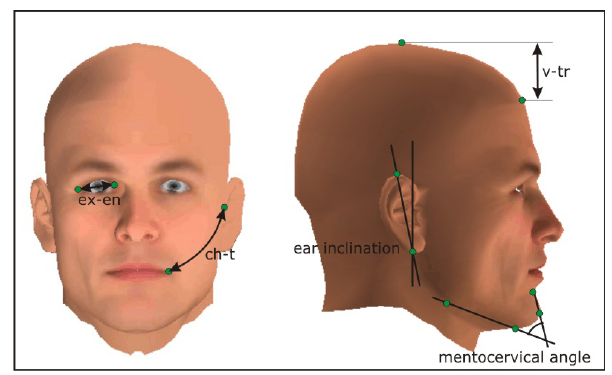
Figure 3. Measures based on landmarks.